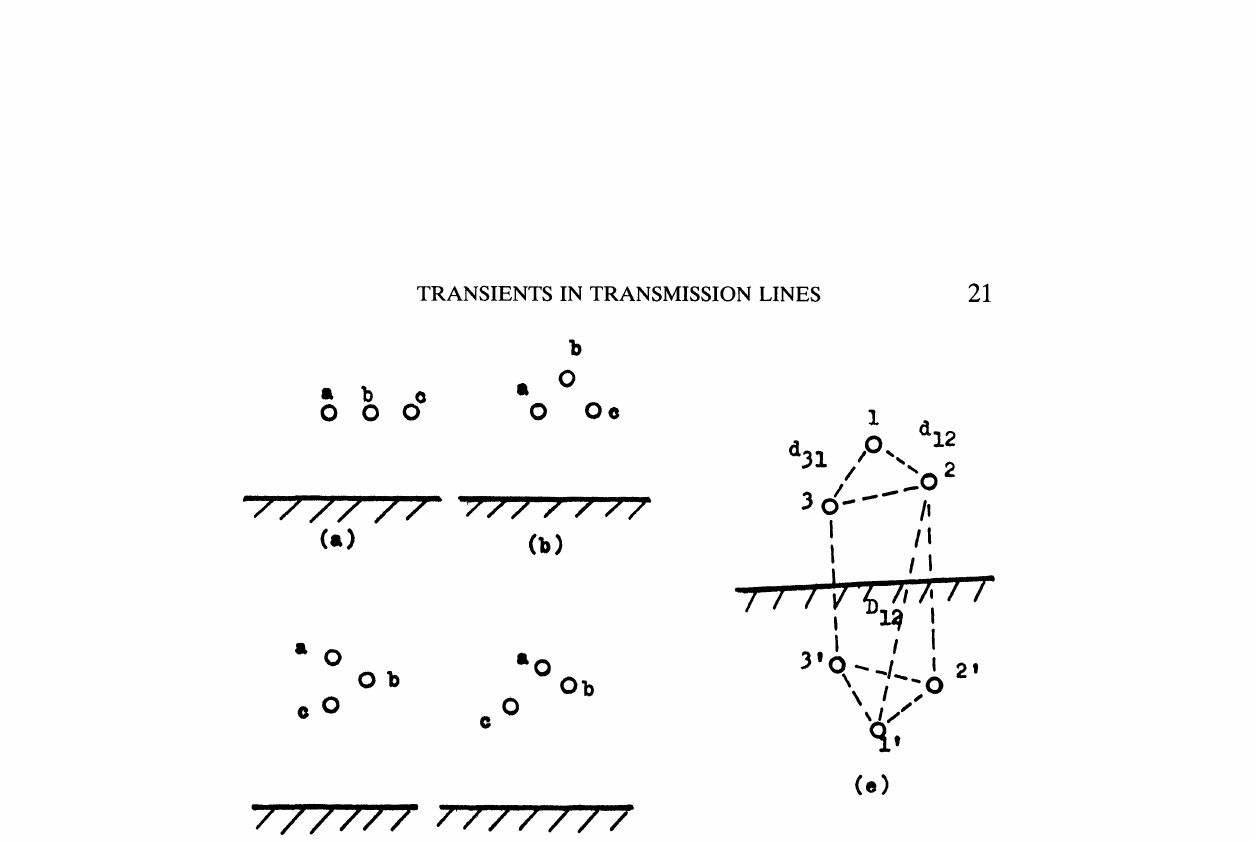
FIGURE The arrangement of phases of typical transmission lines. (a) 750 kV, (b) 330 kV, (c) 330 kV, (d) 220 kV, (ei mirror effect D /DI2D23D31 d /d12 d23 d31.